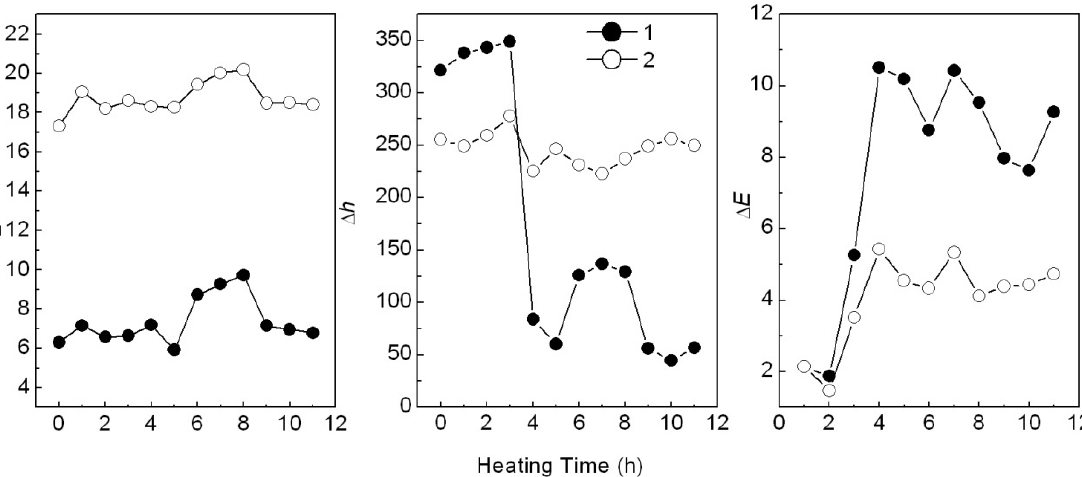
Figure 12. Effect of heating time on L*, h and Δ E of the PP samples colored with the